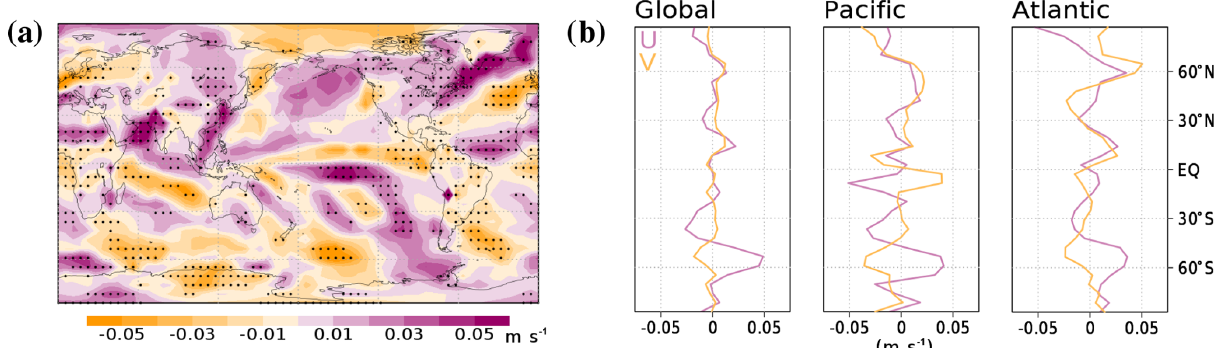
Figure 9. (a) Map of meridional wind differences between MCA and LIA. Dots indicate locations where the differences are significant ( p < 0 . 05). (b) Zonal mean of zonal wind (purple) and meridional wind (yellow) for the composite MCA–LIA for global, central Pacific (180–120 ◦ W), and Atlantic (50–0 ◦ W)